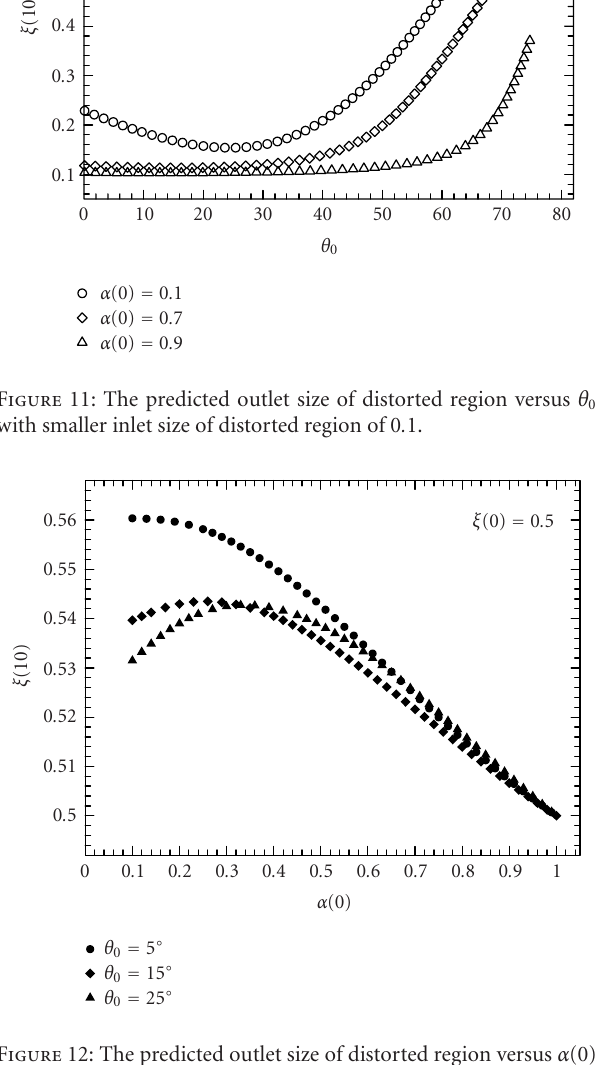
Figure 10: The predicted outlet size of distorted region versus θ 0 with higher inlet size of distorted region of 0 . 5.